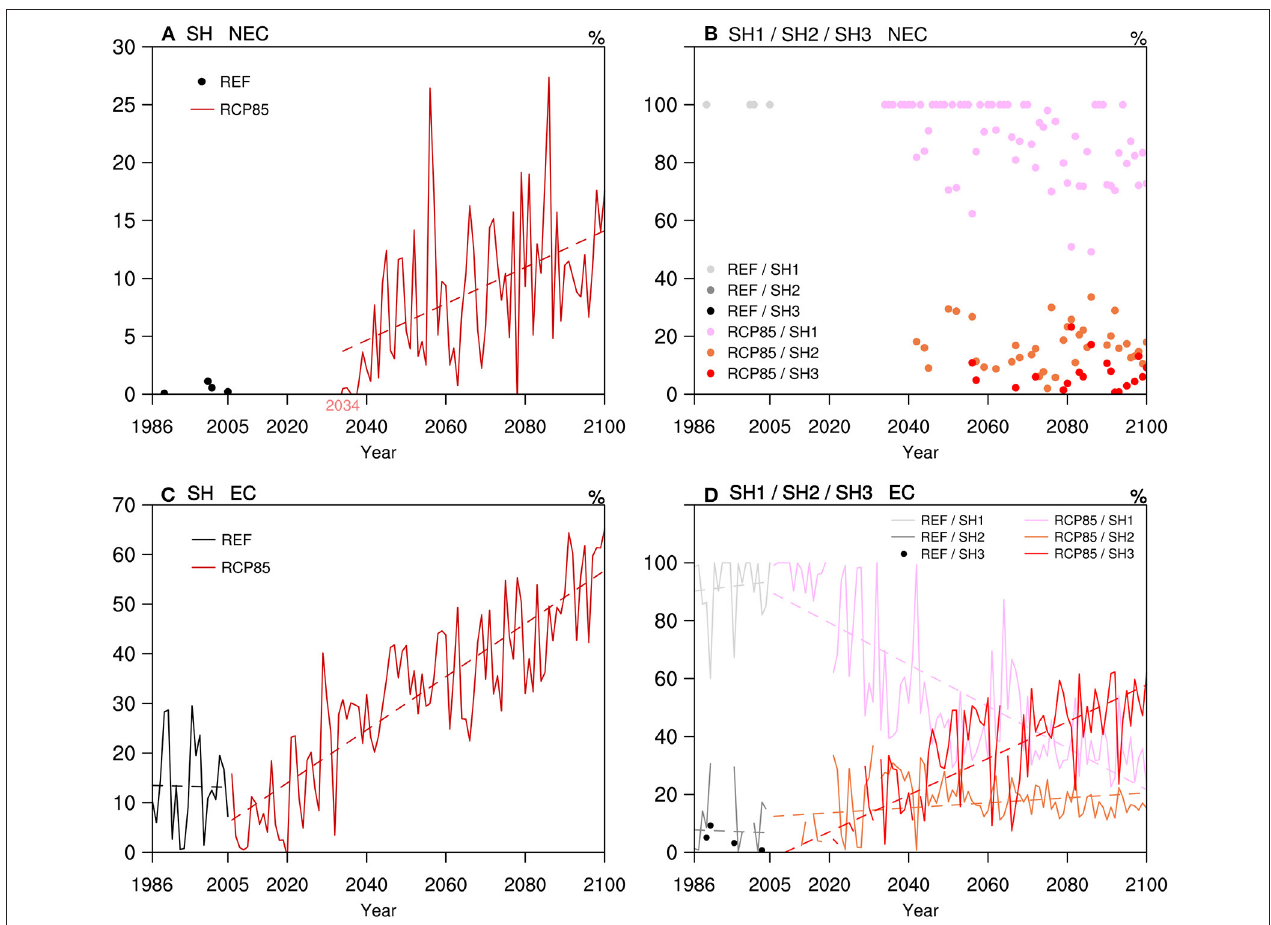
FIGURE 9 | Time series of indexes of regional impact of heat damage (SH, unit: %) and regional coverage of heat damage with different intensity (SH1/SH2/SH3, unit: %) for reference (years 1986–2005) and projected (years 2006–2100 under the RCP8.5 pathway) climate by LMDZ-MME. (A,B) are for regional average of Northeast China, and (C,D) for Central and East China. The light gray, dark gray, and black solid lines denote the historical temporal variations of indexes and magenta, orange, and red solid lines for projection results under RCP8.5 scenario. The corresponding long dashed lines indicate the linear trends of individual